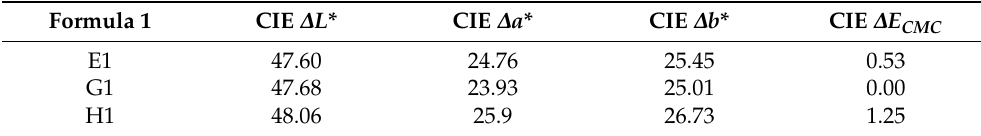
Table 10. The coating color differences of coated panels prepared by Formula